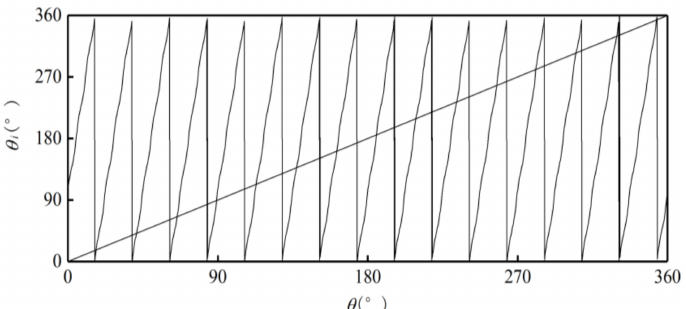
Figure 6. Relationship between ideal angle and single-cycle angle of outer alnico.